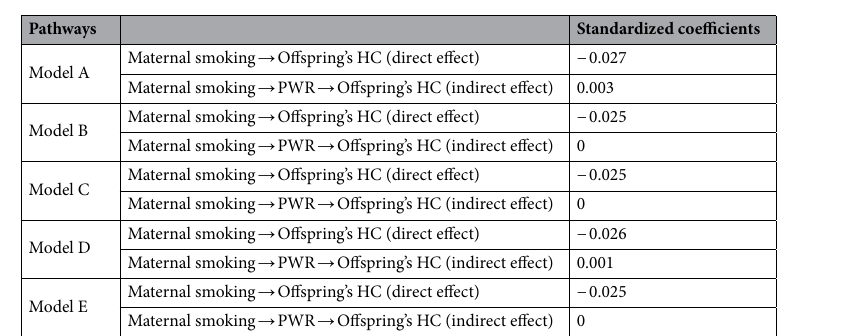
Figure 2. Path analysis for the relationship between maternal smoking toward offspring’s HC, PWR and placental abnormalities ( A , gestation age; B , placenta previa; C , abruption placentae; D , placental calcification; E , placental infarction) showing the standardized estimates with p-values and coefficient of determination ( R 2 ). *: p < 0.05, **: p < 0.01, ***: p < 0.001, (n.s.): not significant. ”e” represent the errors. HC, head circumference; PWR, placental weight ratio.